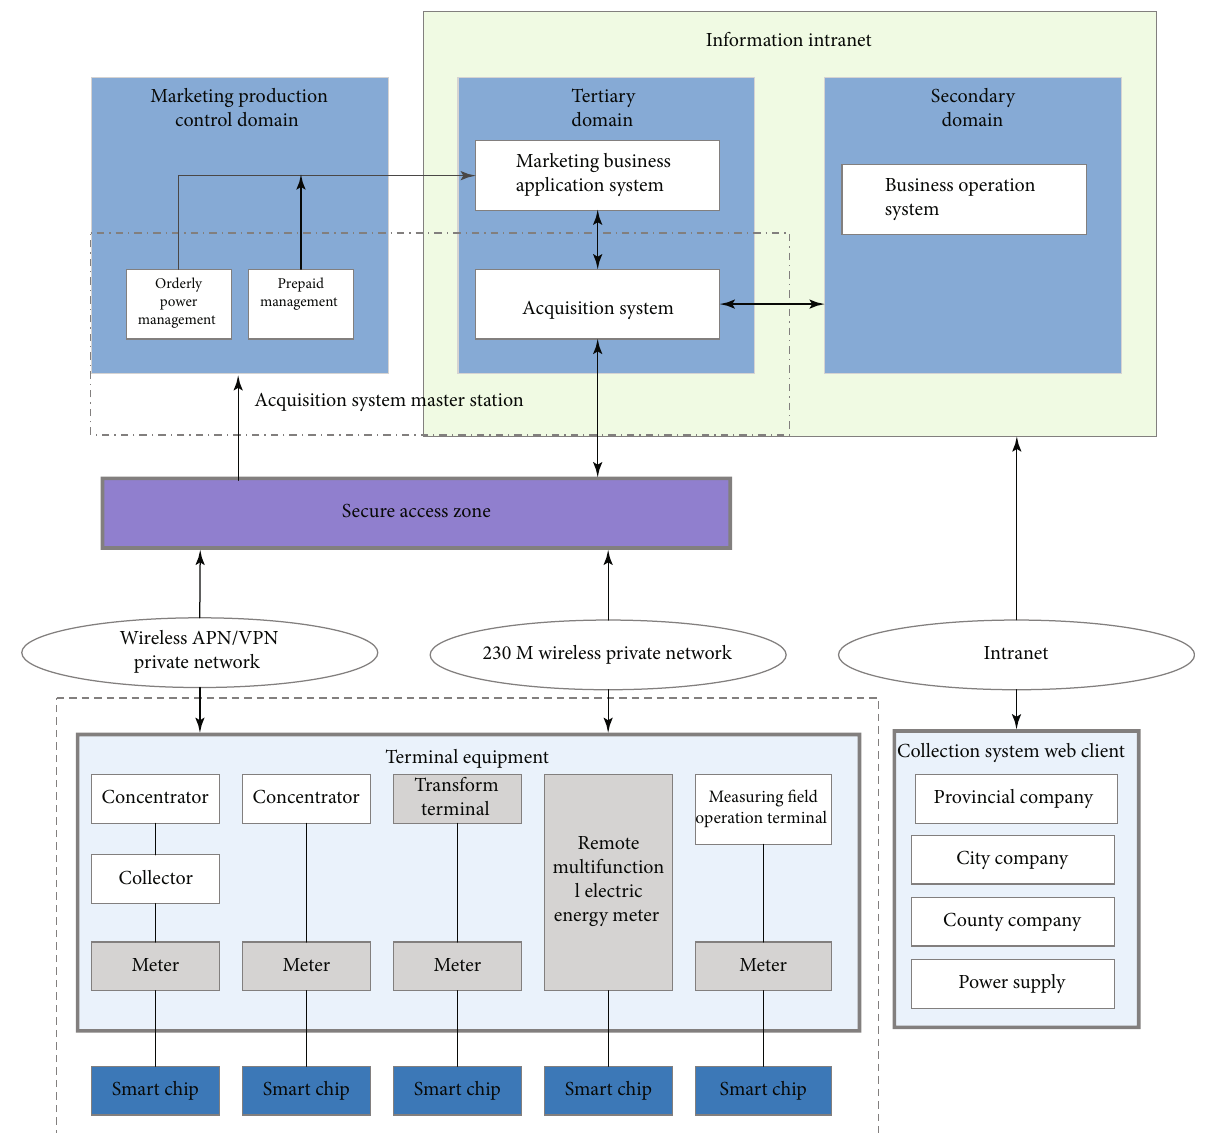
Figure 2: Network topology diagram of electricity collection system based on smart